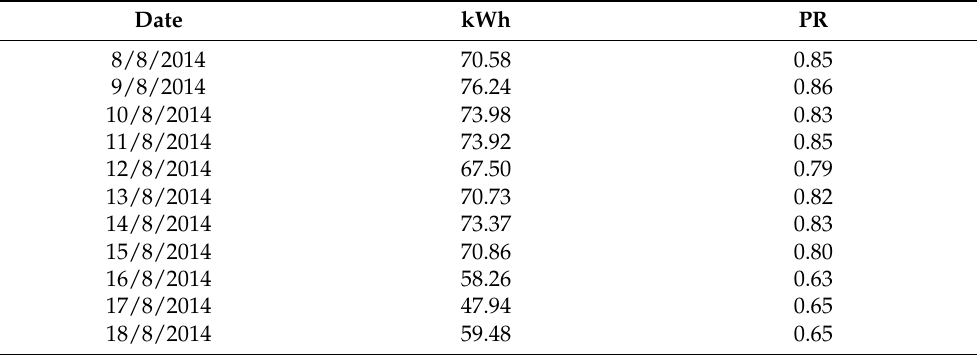
Table 8. Statistical metrics of the deviation between two inverters of the same PVS during June of 2014 for normal